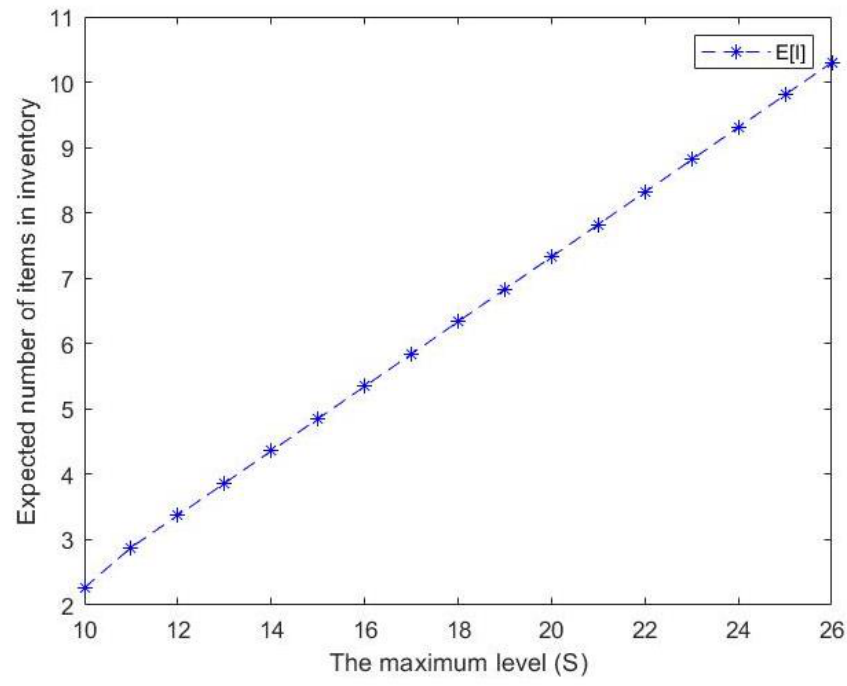
Figure 7. Effect of S on expected number of items in inventory.